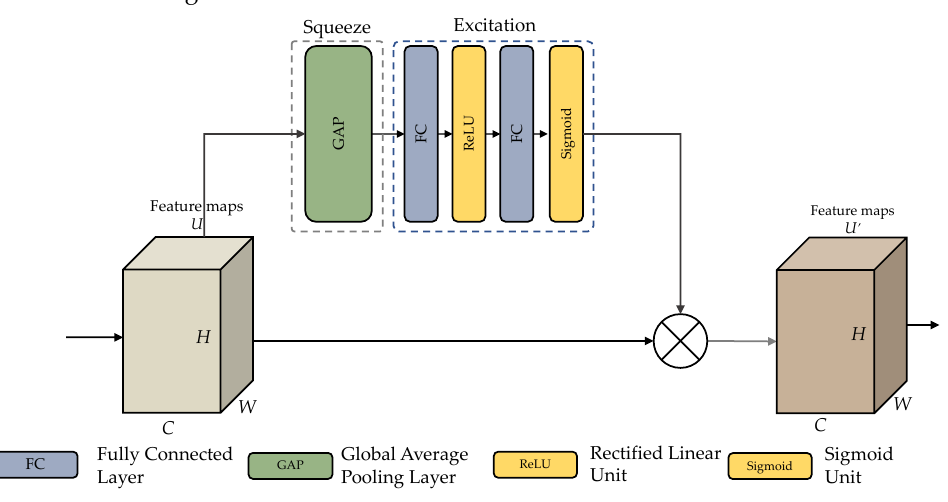
Figure 7. Structure of the SE